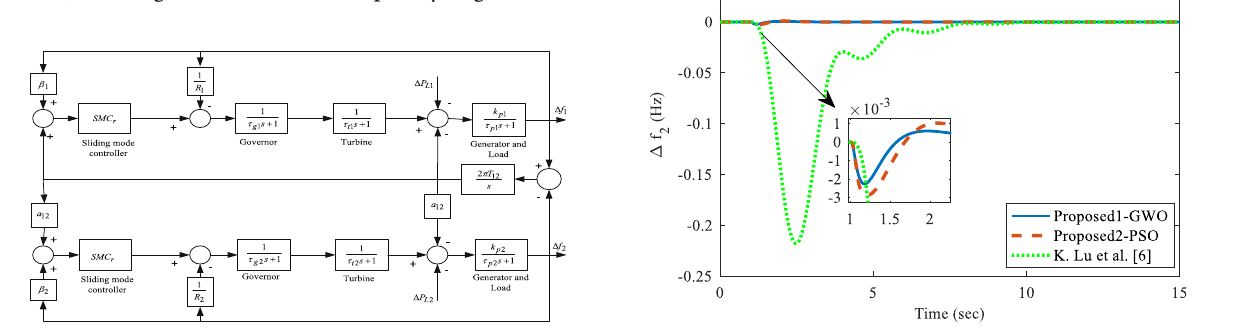
Fig. 11 Frequency regulation in area 2 for case